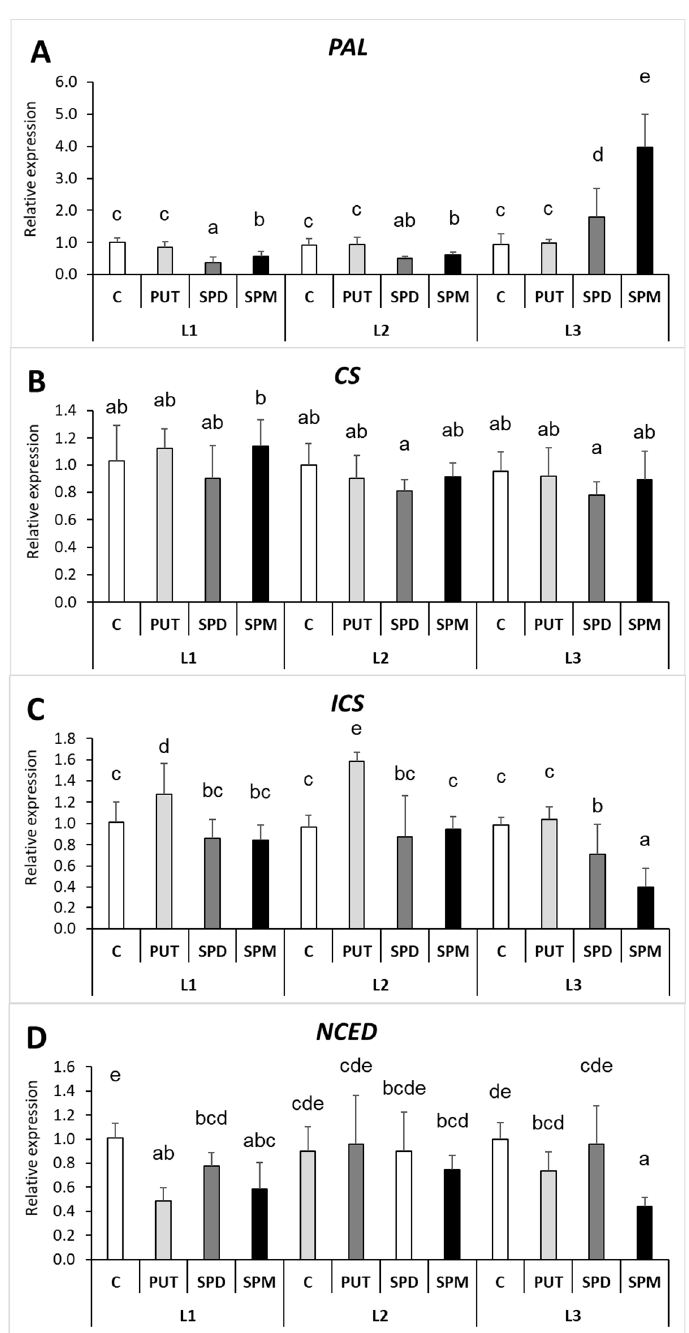
Figure 11. Effect of different light intensities on the gene expression levels of phenylalanine-ammonia-lyase ( A ) ( PAL ), chorismate synthase ( B ) ( CS ), isochorismate synthase ( C ) ( ICS ) and 9-cis-epoxycarotenoid dioxygenase ( D ) ( NCED ) in the leaves of plants grown under 16 h/8 h day/night light period with different light intensity conditions: 500 (elevated light: L1), 250 (medium light: L2) and 50 (low light: L3) μ mol m 2 s − 1 LED light after 7 days of 0.3 mM exogenous putrescine (PUT), spermidine (SPD) or spermine (SPM) treatments or without any treatment ( C ). Data represent mean values ± SD. Different letters indicate significant differences at p ≤ 0.05 level, among all the values of the given compounds.